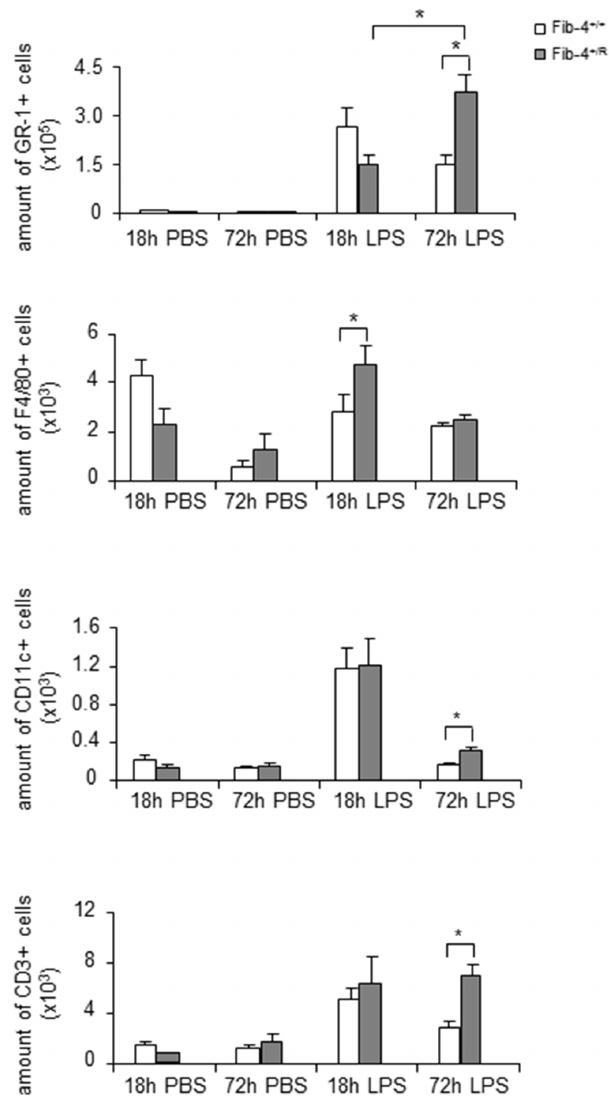
Figure 7. Increased and prolonged inflammatory response in LPS exposed Fibulin-4 + /R mice. Quantification of immune cells shows significantly increased F4/80 + cells after 18 hours of LPS exposure in Fibulin-4 + /R lungs (n=4) and a significantly higher number of Gr1 + , CD11c + , and CD3 + cells after 72 hours of LPS exposure as compared to Fibulin-4 + / + lungs (n=4, *p ,